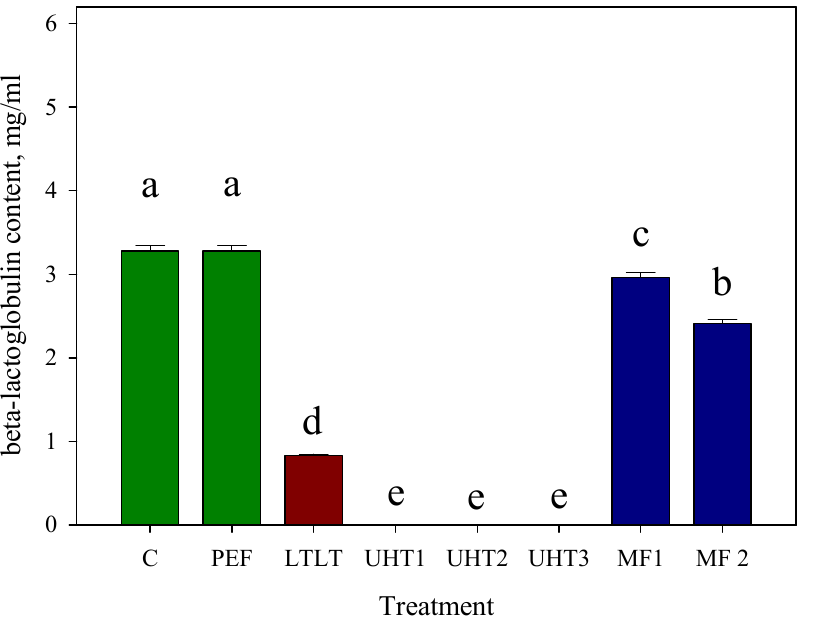
Figure 7. β -lactoglobulin content in milk samples treated with different pasteurization techniques: C—control (raw milk); PEF—pulsed electric field; LTLT—low-temperature long-time; UHT1— ultra-high temperature; UHT2—ultra-high temperature; UHT3—ultra-high temperature; MF1— microfiltration; MF2—microfiltration. Different lowercase letters indicate significant differences between the samples ( p < 0.05).